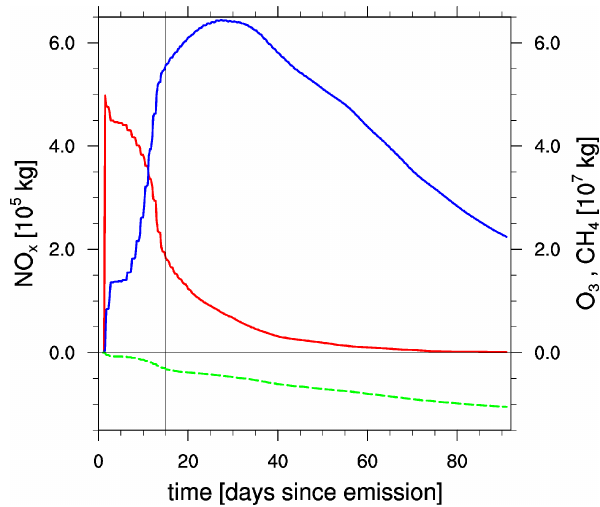
Figure 1. Temporal evolution of the contribution to the global atmo- spheric mass of NO x (red), O 3 (blue), and CH 4 (green) attributed to the emissions in one arbitrary time region within 90d after emis-